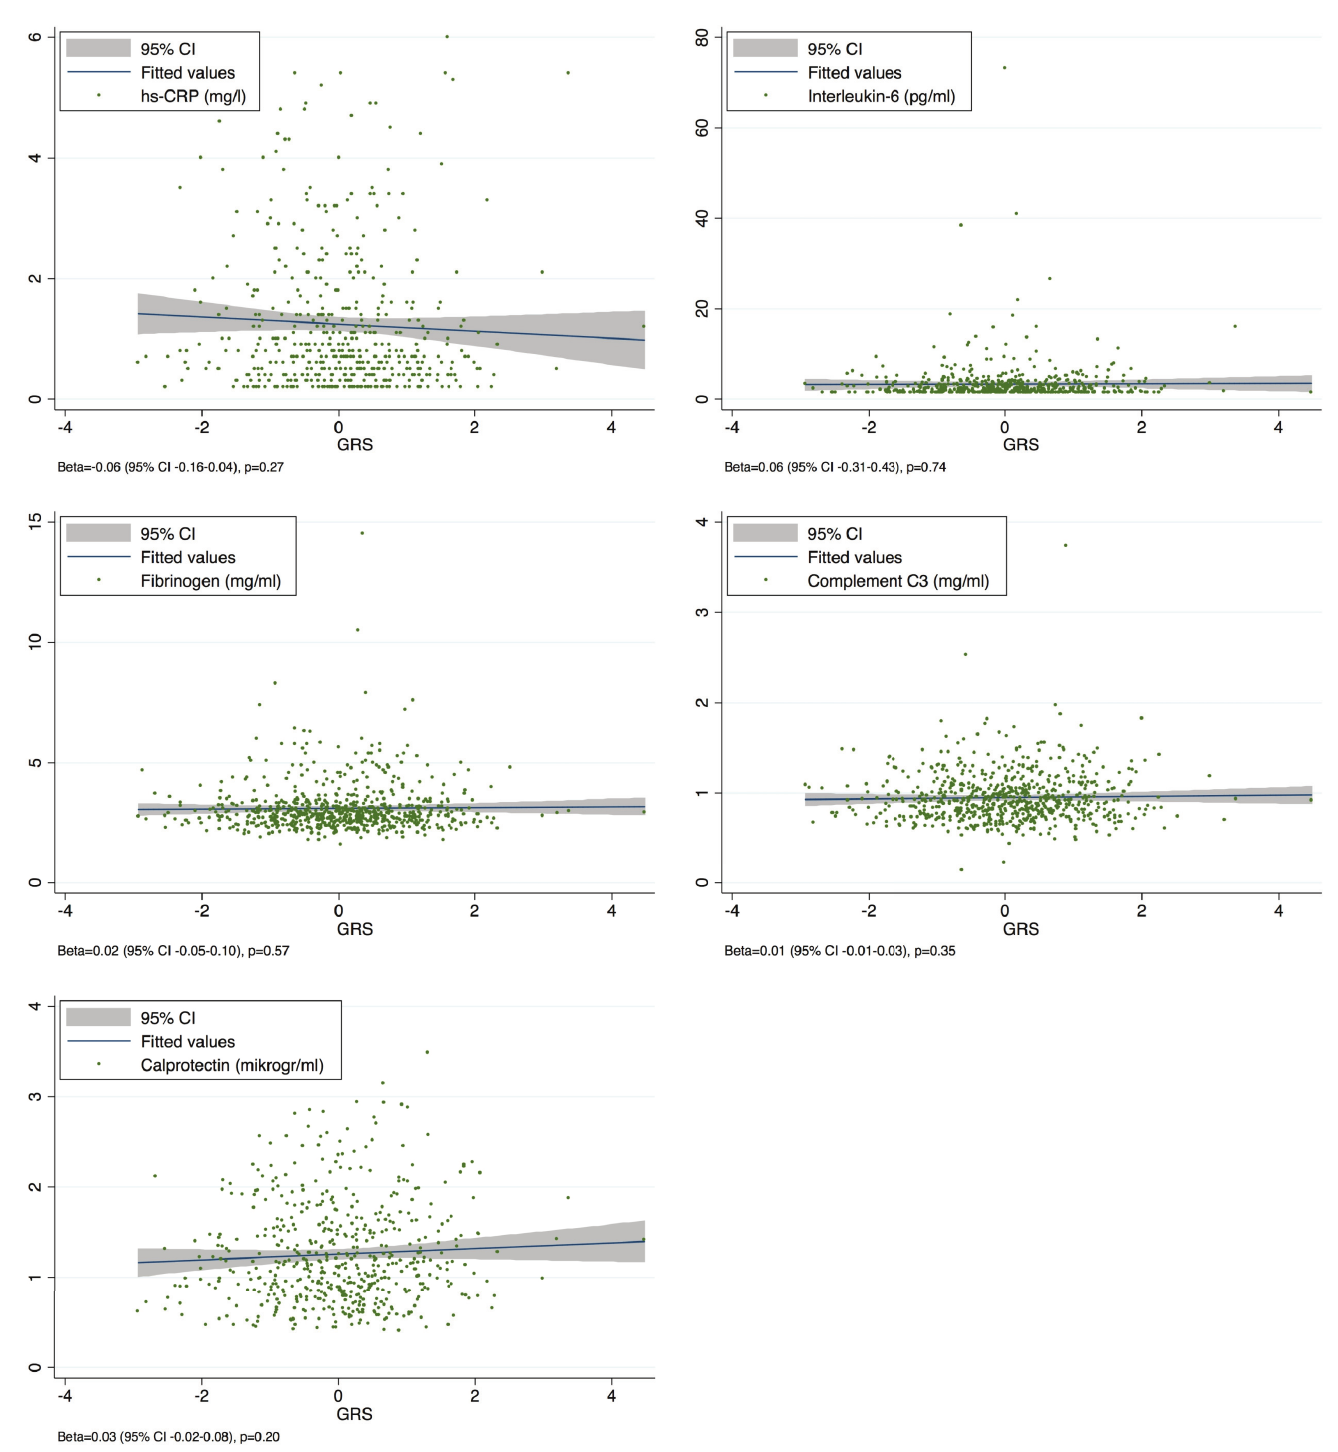
Fig 3. Scatterplots of the association between inflammatory markersand the standardized GRS. Abbreviations: GRS, geneticrisk score; hs-CRP, high-sensitivity C-reactiveprotein.